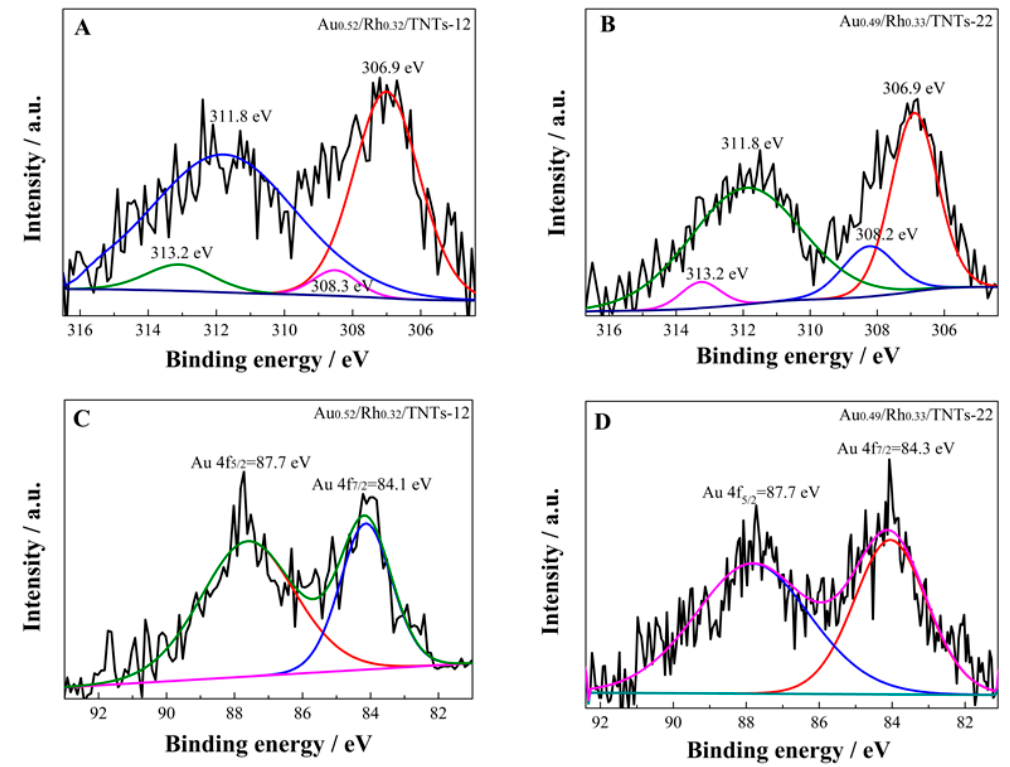
Figure 4. High ‐ resolution XPS spectra of Rh 3d ( A , B ) and Au 4f ( C , D ) for the resultant materials. Figure 4. High-resolution XPS spectra of Rh 3d ( A , B ) and Au 4f ( C , D ) for the resultant